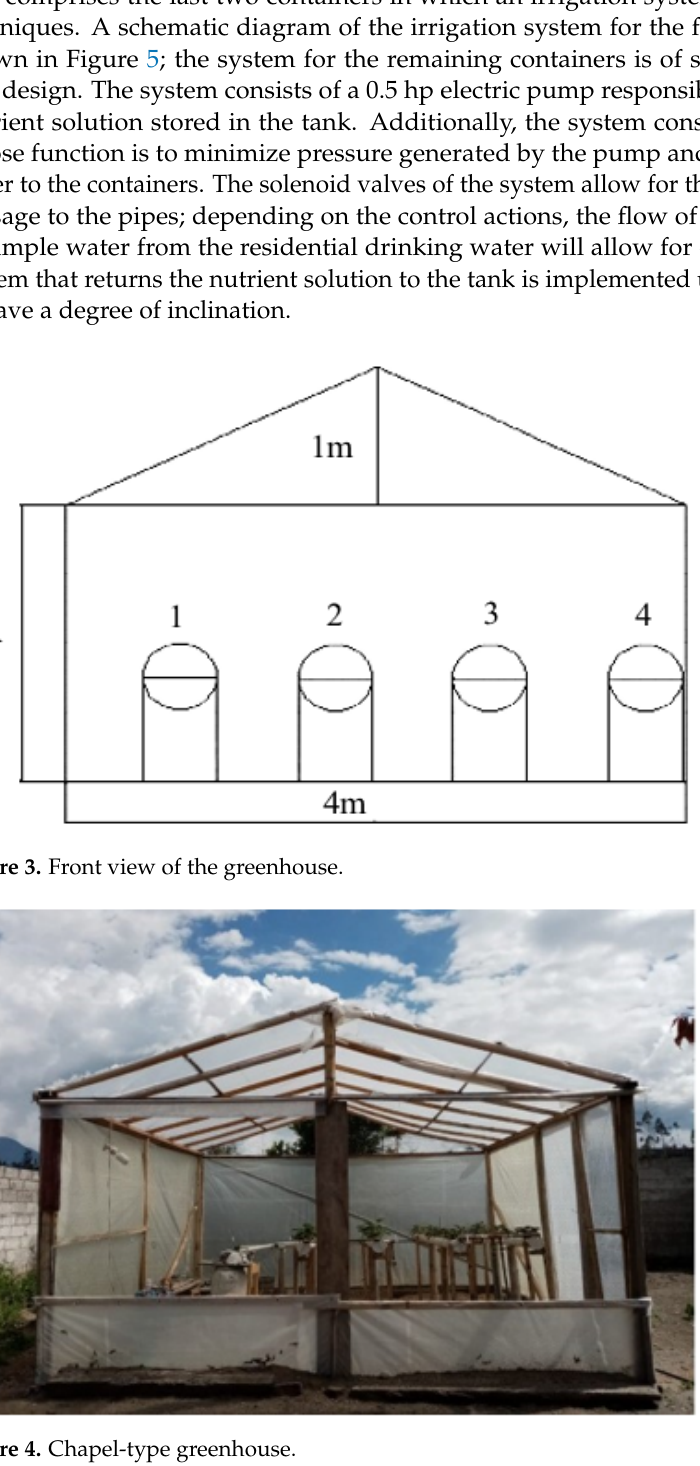
Figure 4. Chapel-type